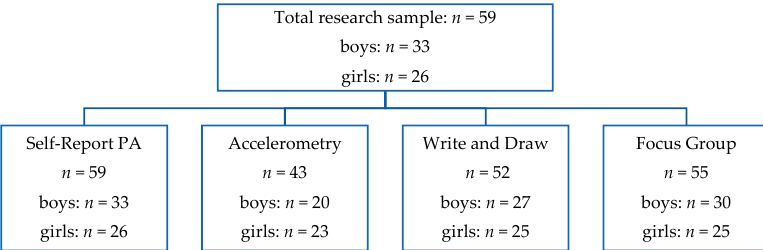
Figure 1. Diagram showing flow of participants throughout the research phases. PA: physical